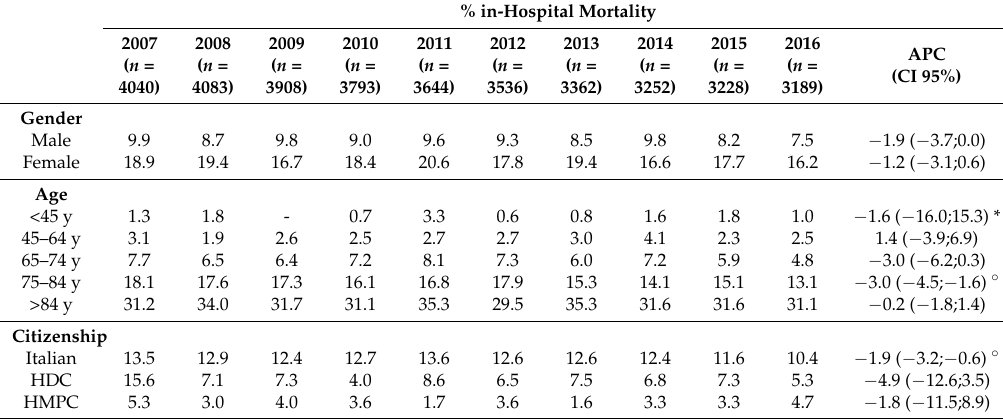
Table 3. Veneto Region 2007–2016. In-hospital mortality after hospital admission for STEMI by gender, age, and citizenship.